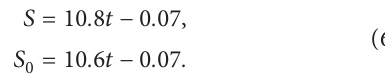
Figure 10: Linear regression of a and a